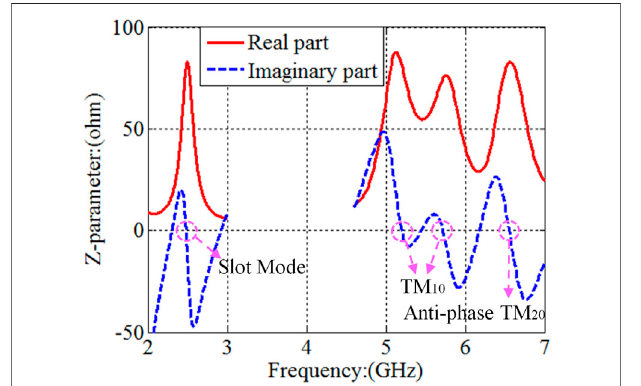
FIGURE 6 | The in fl uence of top metal and solar cells on the radiation patterns at 2.4 GHz: (A) E-plane, (B) H-plane.